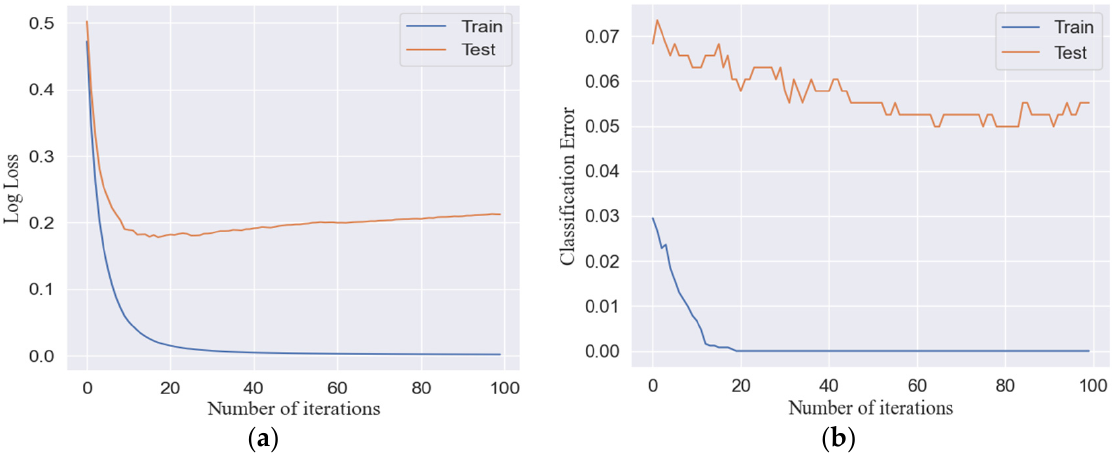
Figure 12. Learning curve for logarithmic loss and classification error on our data with respect to the ensemble classifier in ( a ) log loss and ( b ) classification error.